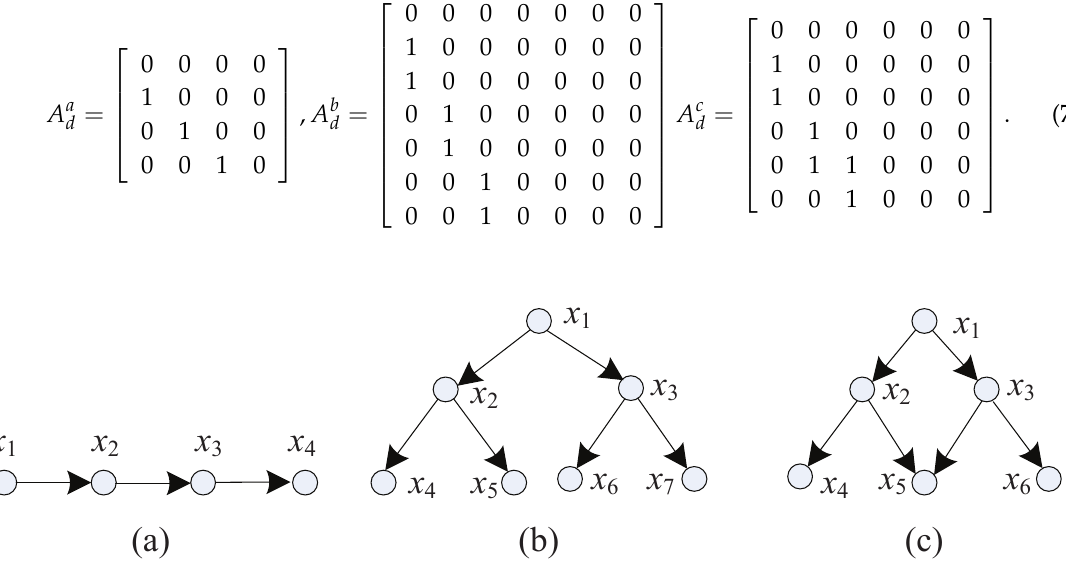
Figure 1. Resovable Group with various structures. ( a ) A chain structure; ( b ) tree structure; and ( c ) complex